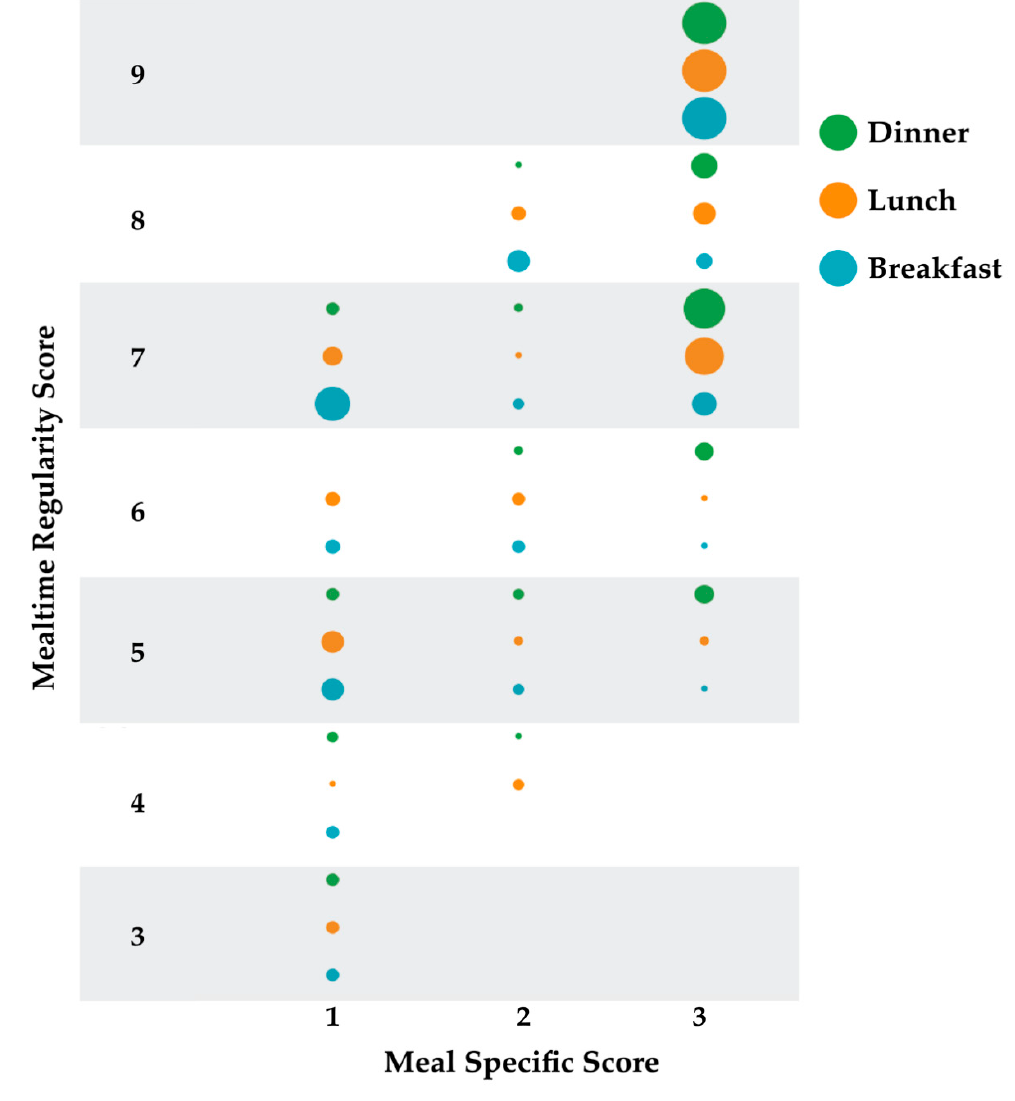
Figure 2. Density distribution of meal-specific scores for each mealtime regularity score. Meal specific scores are 1 rarely/never; 2 often/sometimes; 3 always. Circles represent counts with larger circles indicating more counts. Counts range from 1 [e.g., 1 participant with an mReg1 score of 4 had a score of 1( rarely/never) for lunch; 1 participant with an mReg1 score of 5 had a score of 3 ( always ) for breakfast] to 45 [All persons with an mReg1 score of 9 had a score of 3 ( always ) for each meal].